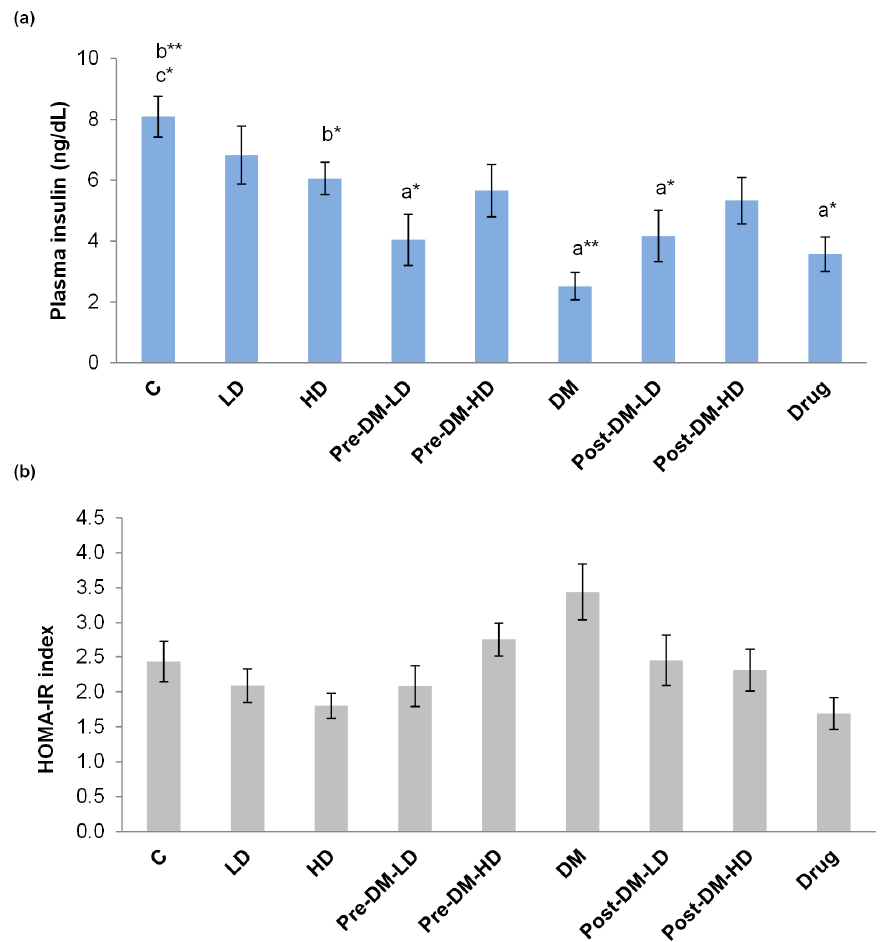
Figure 6. Effect of GBRE supplement on the insulin level ( a ) and insulin resistance; ( b ) in the experimental rats. C: Control, LD: Low dose of GBRE to naïve rat, HD: High dose of GBRE to naïve rat, DM: Diabetes Mellitus induced rat, Pre-DM-LD: Low dose of GBRE to naïve rat and induced DM, Pre-DM-HD: High dose of GBRE to naïve rat and induced DM; Post-DM-LD: Low dose of GBRE to DM rat, Post-DM-HD: High dose of GBRE to DM rat. The significant difference between groups (a = when compared with control group; b = when compared with DM group; c = when compared with the drug group) were represented as * ( p < 0.05), and ** ( p < 0.01).